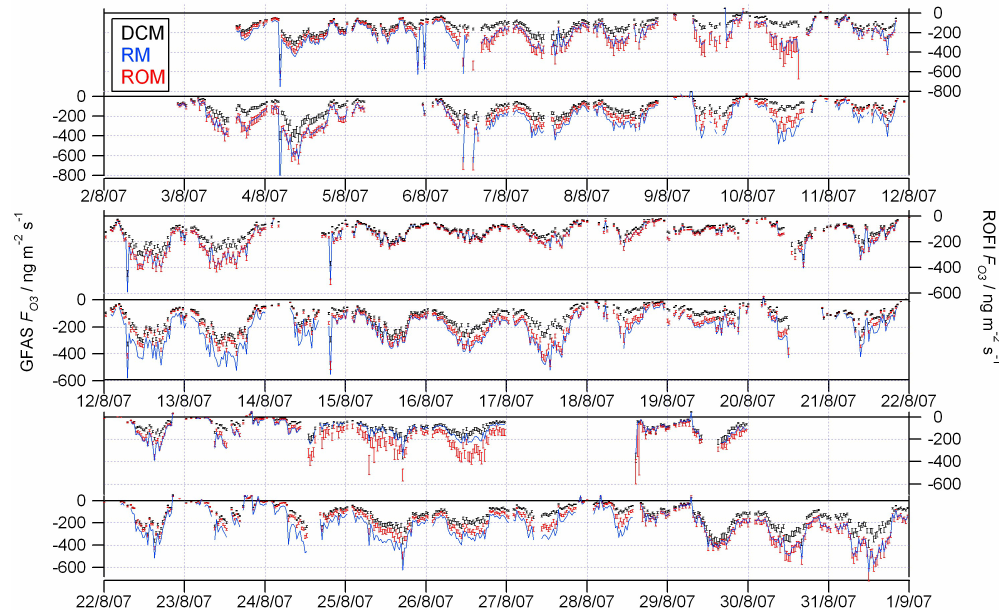
Fig. 2. Time series of ROFI and GFAS fluxes for each calculation method, with error bars based on 2x standard deviation in the parameter fit of the calculation method. Top two panels cover the period 2 August 2007 to 12 August 2007, middle two panels cover the period from 12 August 2007 to 22 August 2007 and the bottom two panels show period 22 August 2007 to 1 September 2007.